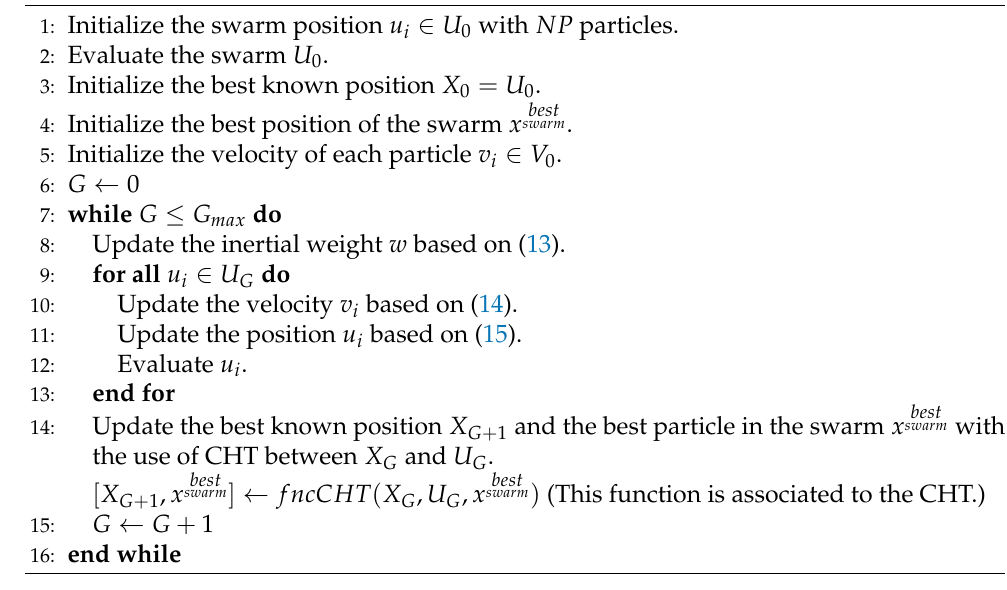
Algorithm 2 Particle swarm optimization